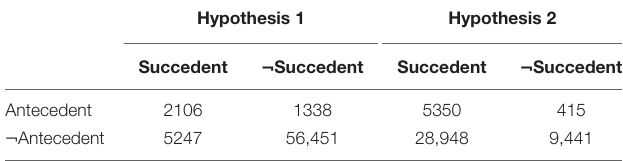
TABLE 4 | Contingency table for analytical question 1 and 2 hypotheses.